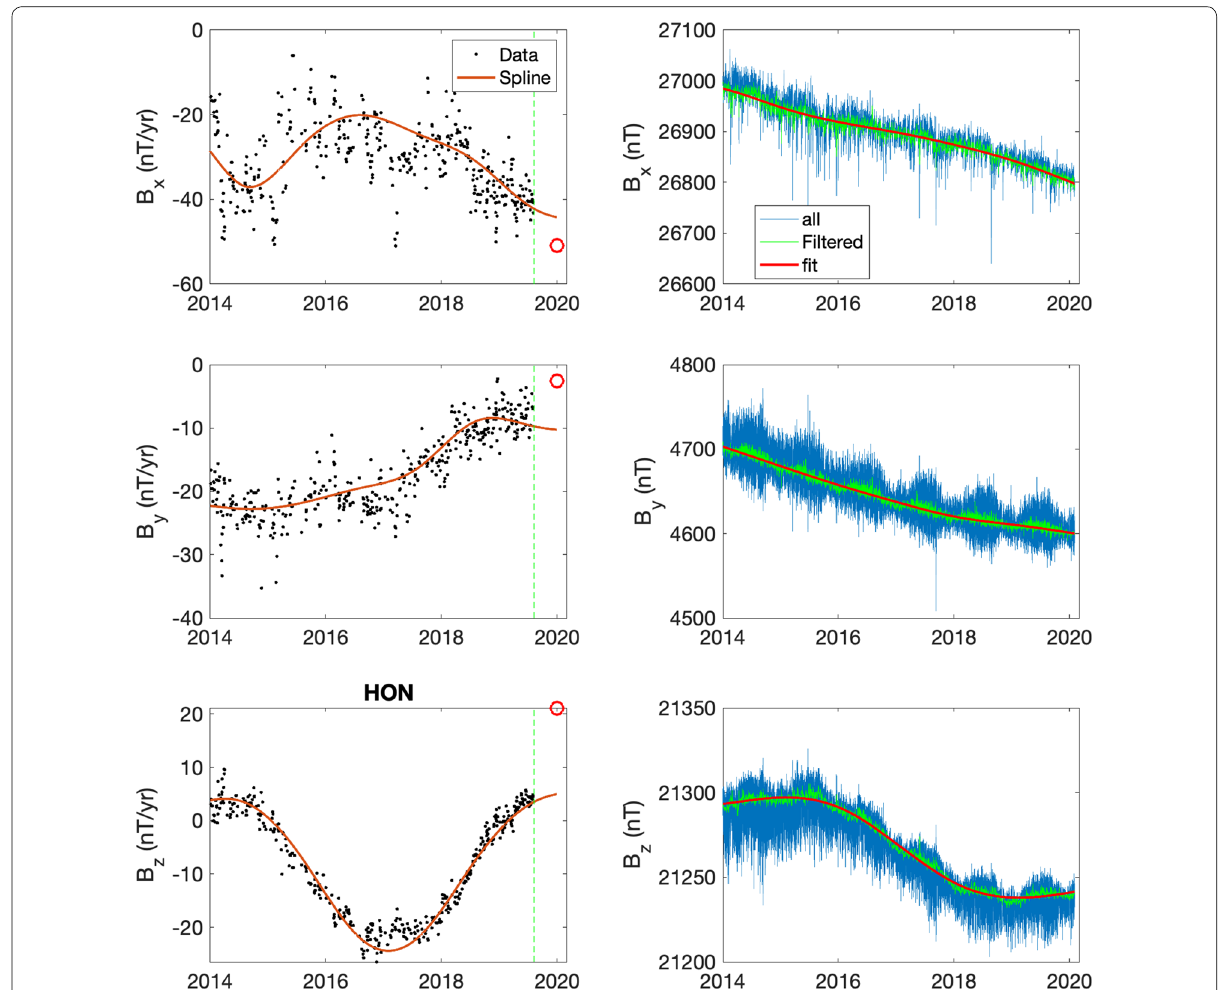
Fig. 3 An example of SV determination at Honolulu (HON). The red lines on the left panels represent the SV spline model with annual differences of filtered observatory data in black. Right panels show the raw data (blue), filtered data (green), and spline fits (red). The circles in the left panel show our predicted SV at 2020.0. The vertical green lines indicate the timestamp of the latest available SV estimate which did not require spline extrapolation